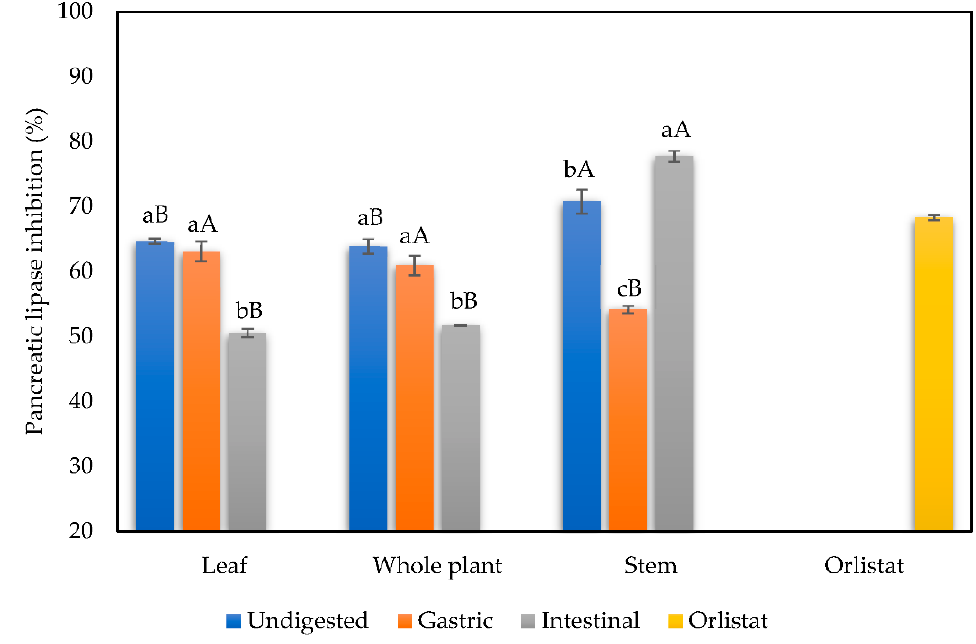
Figure 5. Pancreatic lipase inhibition of mistletoe infusions before and after gastrointestinal in vitro digestion. Data shown as means ± SD values with at least three replicates (n = 3). Means that do not share lowercase letters are significantly different by the Tukey test ( p < 0.05). Means that do not share capital letters show statistical differences between values per plant part in each digestive phase by the Tukey test ( p <